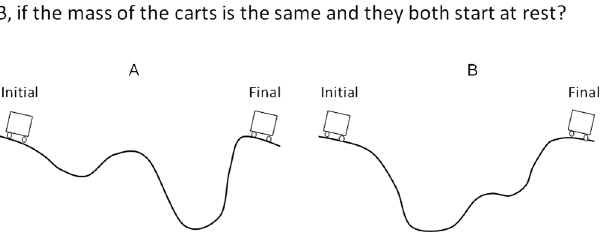
FIG. 2. Example of four ‘‘similar’’ problems used in the roller coaster problem set in the study.